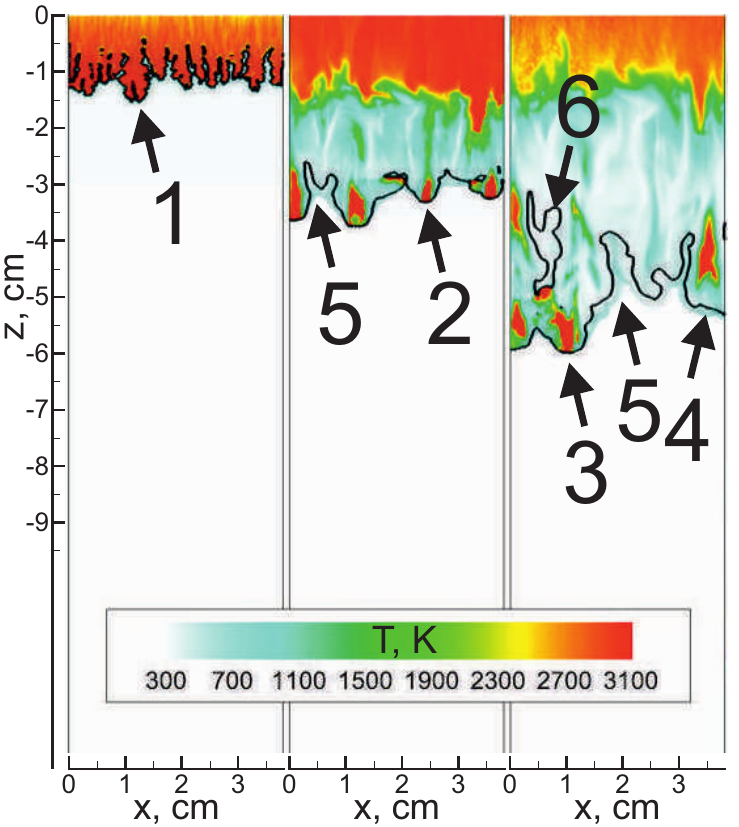
Figure 6. Numerically obtained flow pattern in the process of flame acceleration and detonation propagation in the foam bubbled with 2H 2 + O 2 mixture in 37 mm channel. Time instants are: 40, 50, and 60 µ s. 1—flame front, 2—local explosion, 3—decaying stage of the local explosion, 4—quenched kernel, 5—jet of combustion products, 6—unreacted pocket behind the leading front. Black line indicates the boundary of combustion products region. Calculation with account of droplet